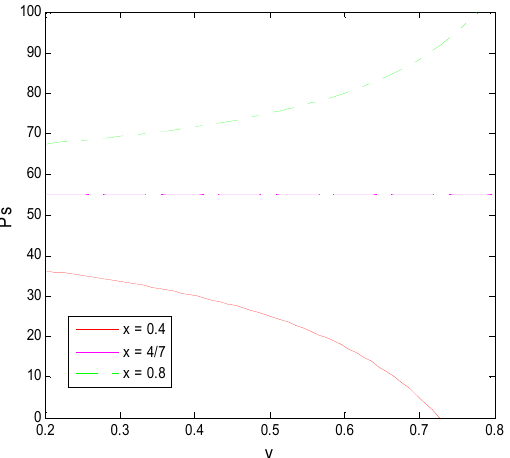
Figure 16. The effect of the income distribution coefficient on the technological transaction prices.